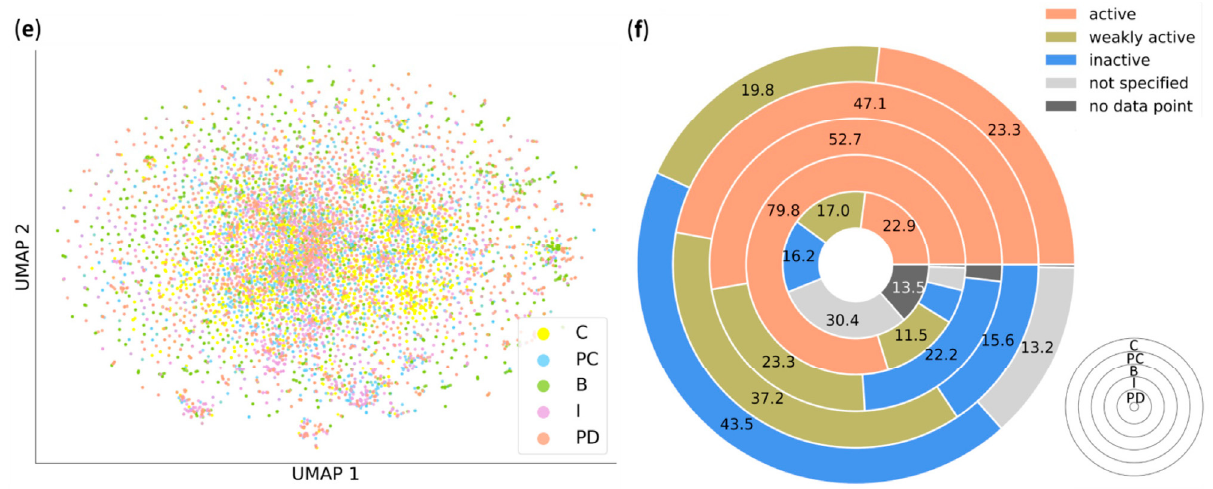
Figure 1. Analysis of individual compound/bioactivity databases to assemble a consensus dataset (C = ChEMBL, PC = PubChem, B = BindingDB, I = IUPHAR/BPS, and PD = Probes & Drugs). From PubChem, only compounds that were also included in at least one of the other databases were considered and the data in PubChem referring to these compounds were used to validate and curate chemical structure and biological activities. ( a , b ) Venn diagrams of the data collected from the five different databases and created by compound ID ( a ) or SMILES ( b ). The numbers of shared and not ‐ shared molecules are reported and the numbers of unique scaffolds are in round brackets. ( c ) The five ‐ most frequently occurring Murcko scaffolds present in the databases. ( d ) Distribution of mo ‐ lecular weight (MW), number of aromatic rings, rotatable bonds, and octanol–water partition coef ‐ ficients (cLogP) per database. ( e ) UMAP of 2000 randomly selected molecules from each database. ( f ) Percentage pie chart of records labeled as active (activity log ‐ value higher than 6), weakly active (activity log ‐ value between 5 and 6), inactive (activity log ‐ value lower than 5 or labeled inactive), not specified (no activity log ‐ value), and no data point. Each ring represents a database in the order shown in the legend. Percentages below 5% are not displayed.